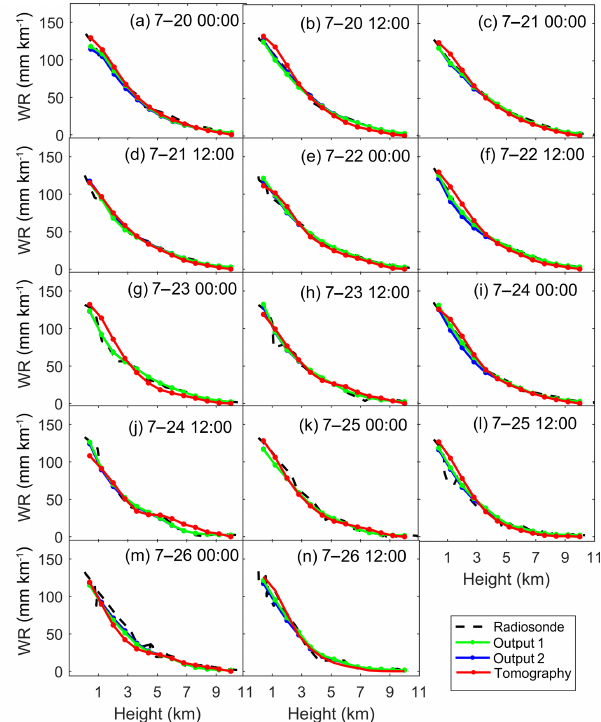
Figure 4. Comparisons among WR derived from Output1, Output2, tomography, and radiosonde in the wet period,